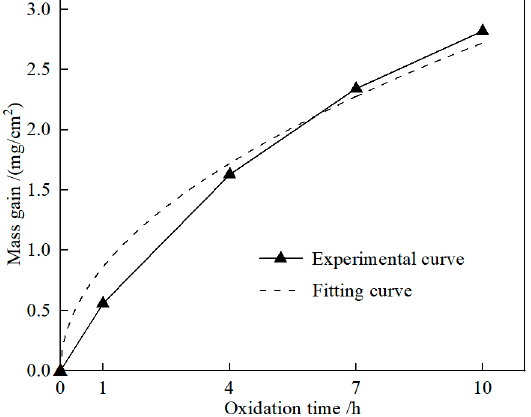
Figure 5. Experimental and fitting curve of oxidation duration and mass gain of TBHB at 1100 °C.